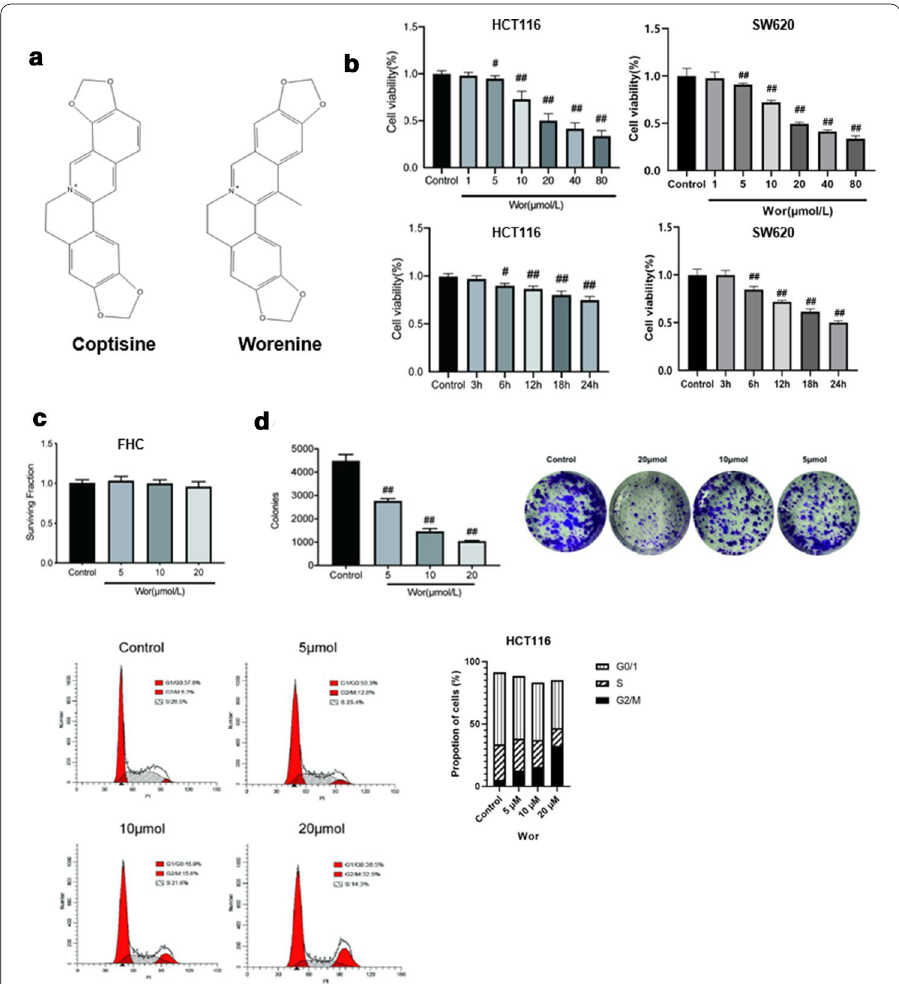
Fig. 1 Worenine reduces cell viability and impairs cell cycle progression. a The chemical structures of coptisine and worenine. b HCT116 and SW620 cells (1 10 4 cells per well) were treated with various × concentrations of worenine (0, 1, 5, 10, 20, 40 or 80 μM) for 24 h. HCT116 and SW620 cells (1 10 4 cells × per well) were treated with 20 μM worenine for 3, 6, 12, 18 or 24 h. Cell viability was detected using the MTT assay. c FHC cells were treated with worenine for 24 h at the indicated concentrations. d The colony formation rates of HCT116 cells treated with various concentrations of worenine (5, 10 or 20 μM) for 24 h. The percentage values are based on comparison with the control group. e Cell cycle profiles of HCT116 cells treated with various concentrations of worenine (5, 10 or 20 μM) for 24 h. The data are means SEM. ± # p < 0.05, ## p < 0.01 vs. control